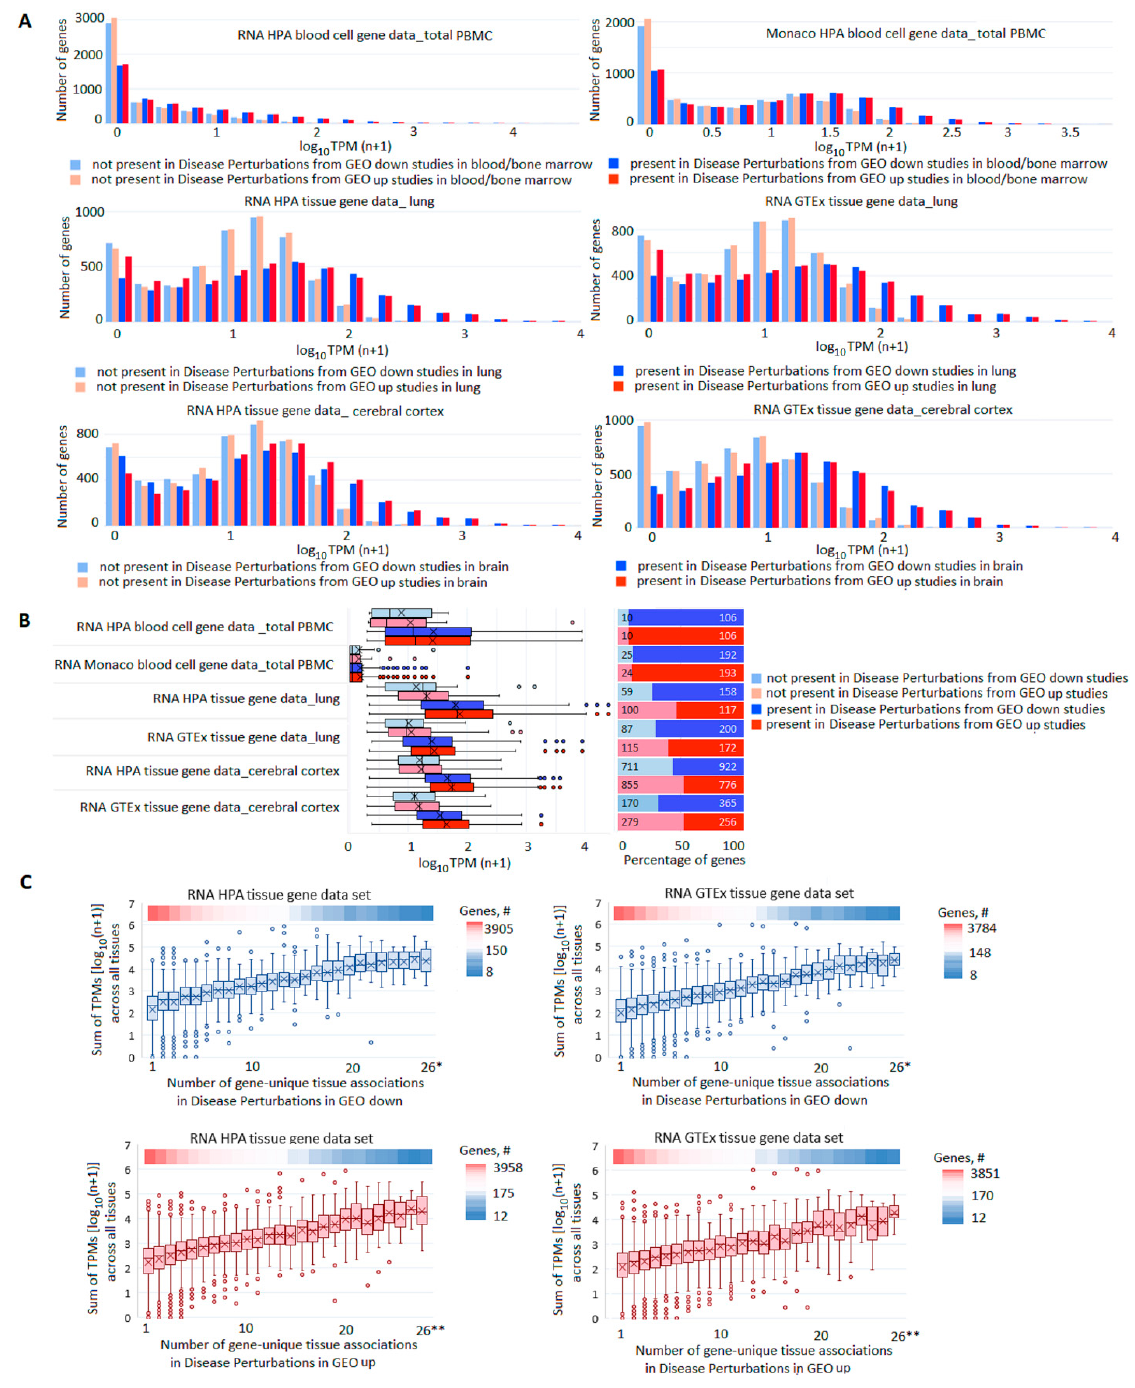
Figure 3. Comparison of gene expression profiles in norm and pathology. ( A ) Distribution of genes by their presence/absence in GEO studies’ libraries in dependence on their expression level in corresponding normal tissues. For all pairs of compared sets, the differences in expression levels between genes present or absent in GEO libraries were highly significant ( p value < 1 × 10 − 300 ). ( B ) Expression levels (left panel) and the number (right panel) of tissue-specific genes present/absent among DE genes in GEO libraries. ( C ) Box plots reflecting correlations between the sum of TPMs across all tissues in HPA or GTEx data sets and the number of GEO tissues in which the expression of the gene changed. The upper heatmap band on each panel reflects the number of genes at each point; * 26 – 28; ** 26 – 30.